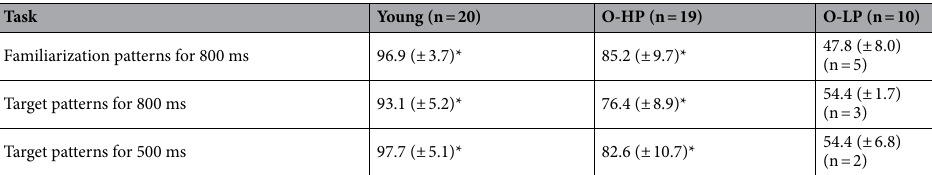
Table 1. Performance of the different groups. Mean accuracy values over all blocks needed per participant are shown in % ± standard deviation for each step of the tactile recognition task. Group comparisons between Young and O-HP were calculated at each step of the recognition task with a two-sided t-test and BY correction for multiple comparisons. *Indicate significant differences between Young and O-HP, all p-values ≤